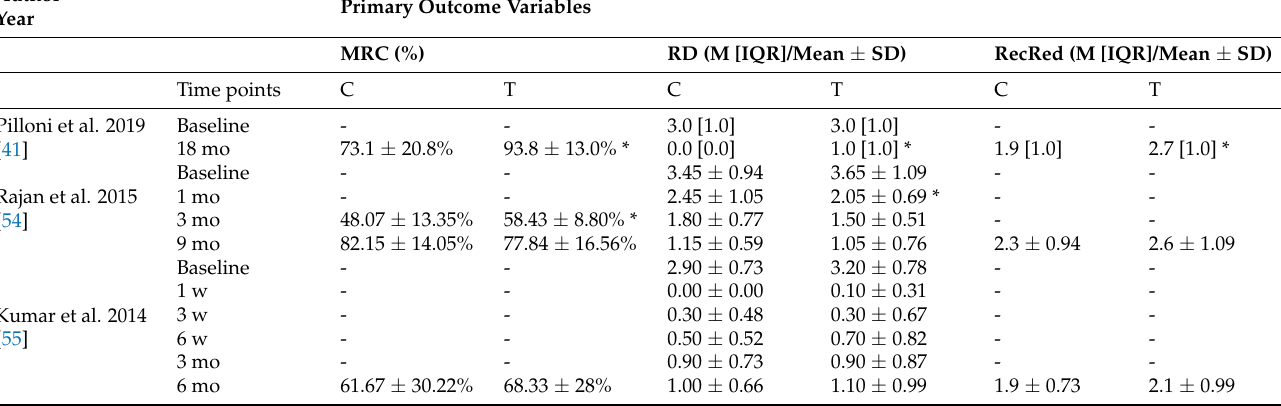
Table 3. Primary outcome